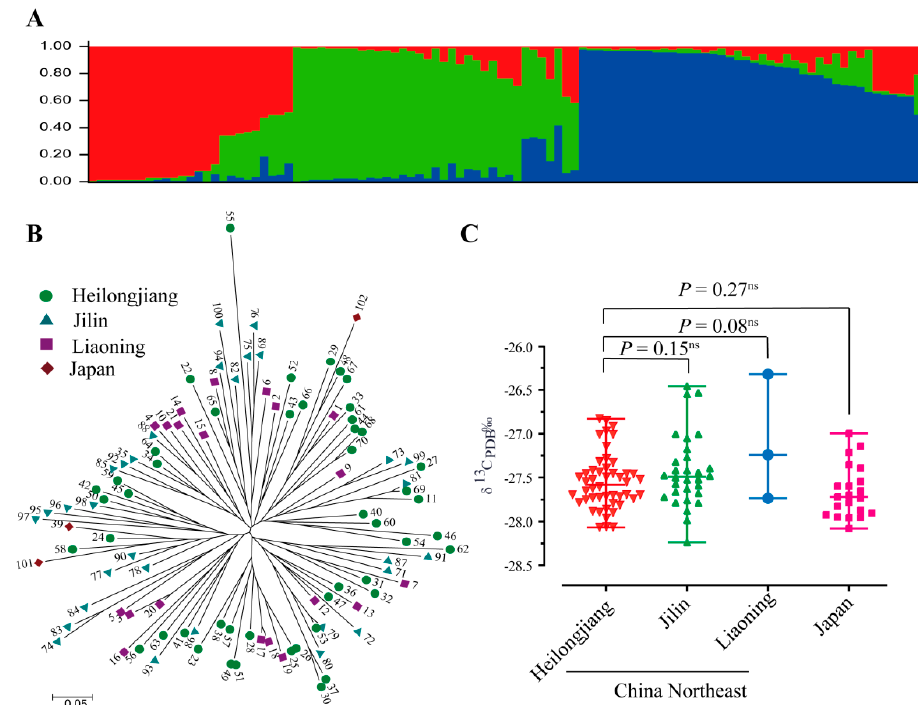
Figure 1. Natural variation in δ 13 C values in 102 rice accessions derived from different geographic regions. ( A ) Population structure analysis of 102 rice accessions. ( B ) Polygenetic analysis of 69 SSR markers in 102 rice accessions. ( C ) Distribution of δ 13 C in accessions originating from different geographic regions.